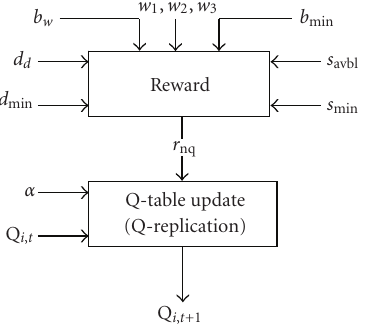
Figure 2: Q-table update (Q-replication).